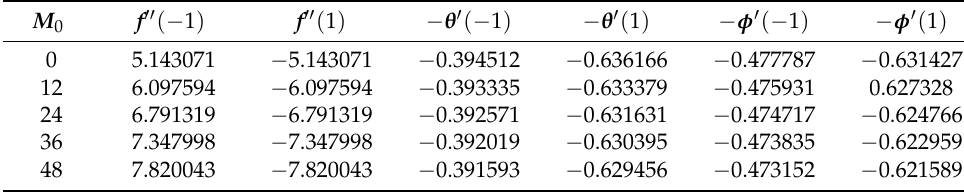
Table 4. Shear stresses, heat and mass transfer rates for various values of M 0 .